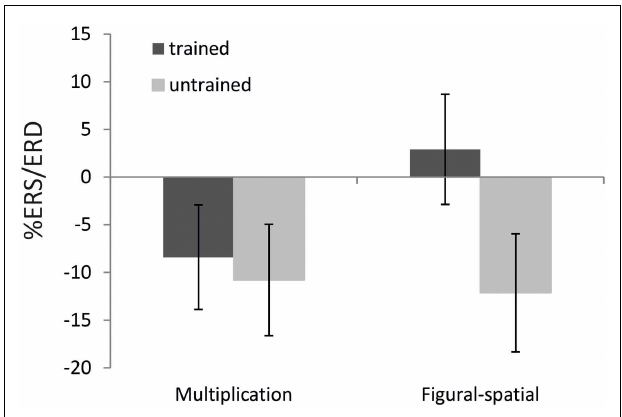
FIGURE 5 | Effect of training as a function of task on %ERS/ERD in the lower alpha band (8–10Hz). Error bars depict 1 SE of the mean.